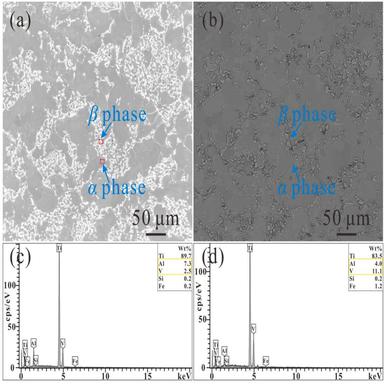
SEM images of microstructures and analysis of composition distribution detected on the etching surface of TC4 titanium alloy specimen: (a) SE photo of a micro-region on the etching surface; (b) BSE photo of a micro-region on the etching surface; (c) EDS analysis of the rectangular region of α phase in (a); (d) EDS analysis of the rectangular region of β phase in (a).